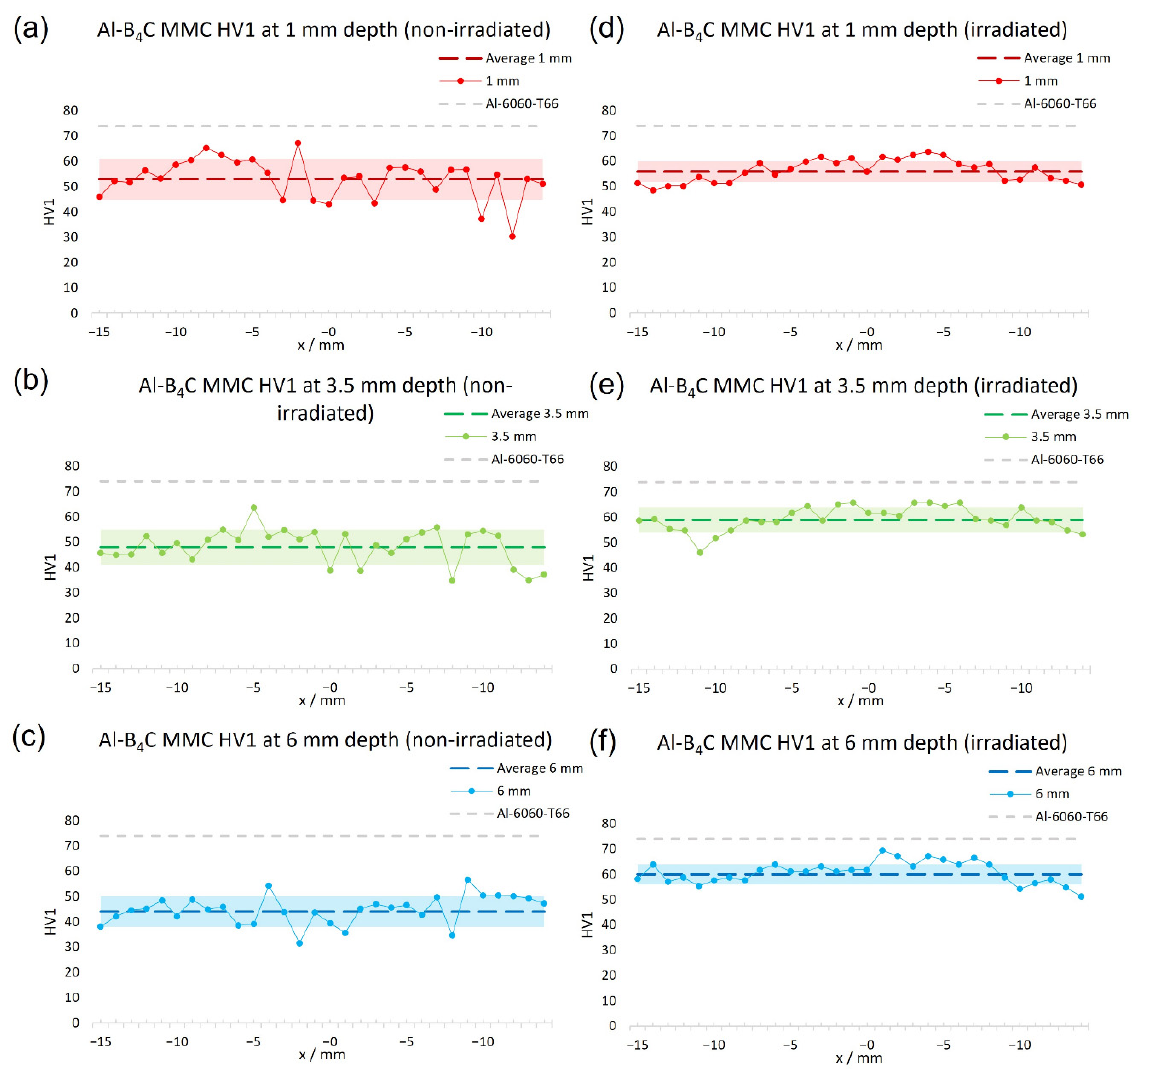
Figure 5. Hardness profile of non-irradiated FSAP Al-B 4 C MMC ( a – c ) and irradiated FSAP Al-B 4 C MMC ( d – f ). Samples were produced according to the method described in Section 2 (Three-pass FSAP). Average hardness is depicted by a dashed line. Standard deviation is represented by shaded areas (details in Table 5). x: distance from the axis of the R3 tool (see Figure 2).